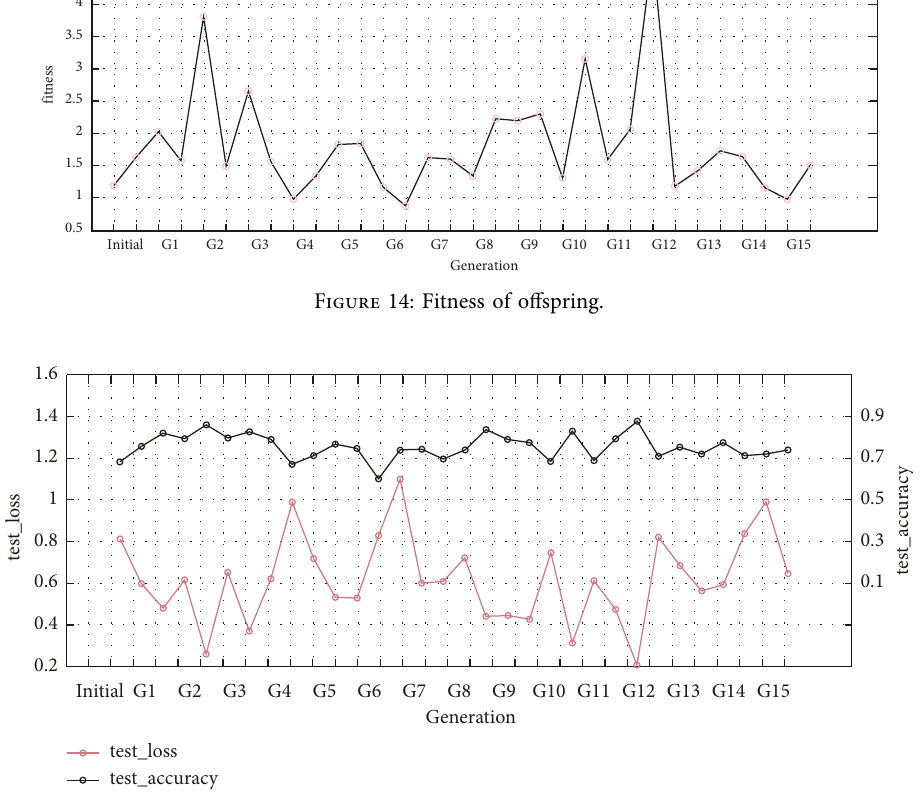
Figure 15: Loss and accuracy of generated networks on test set. Table 4: Optimal solution network structure.